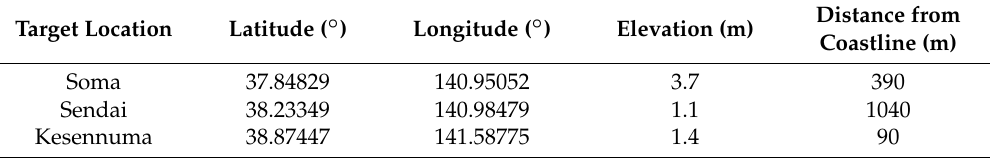
Table 1. Location information for the target buildings in each city.